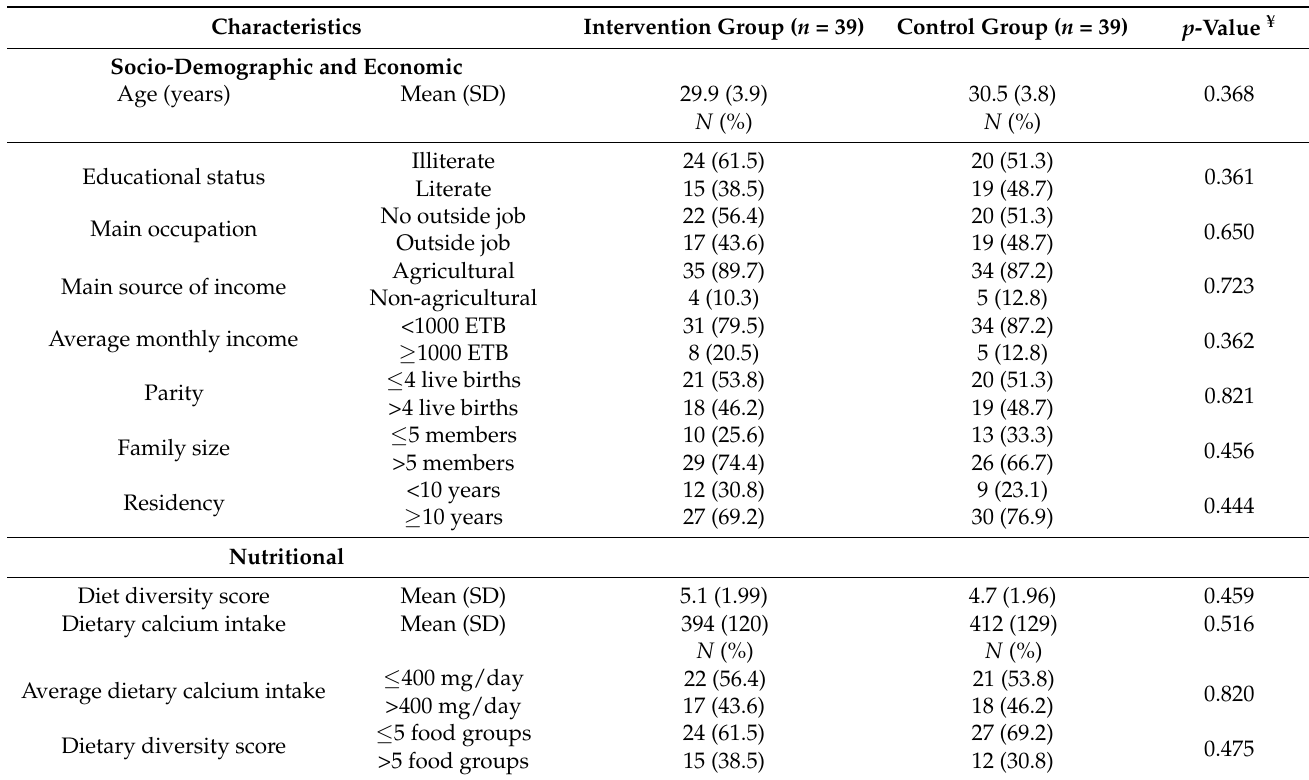
Table 1. Baseline socio-demographic, economic and nutritional characteristics of study participants, Halaba district, southern Ethiopian Rift Valley,